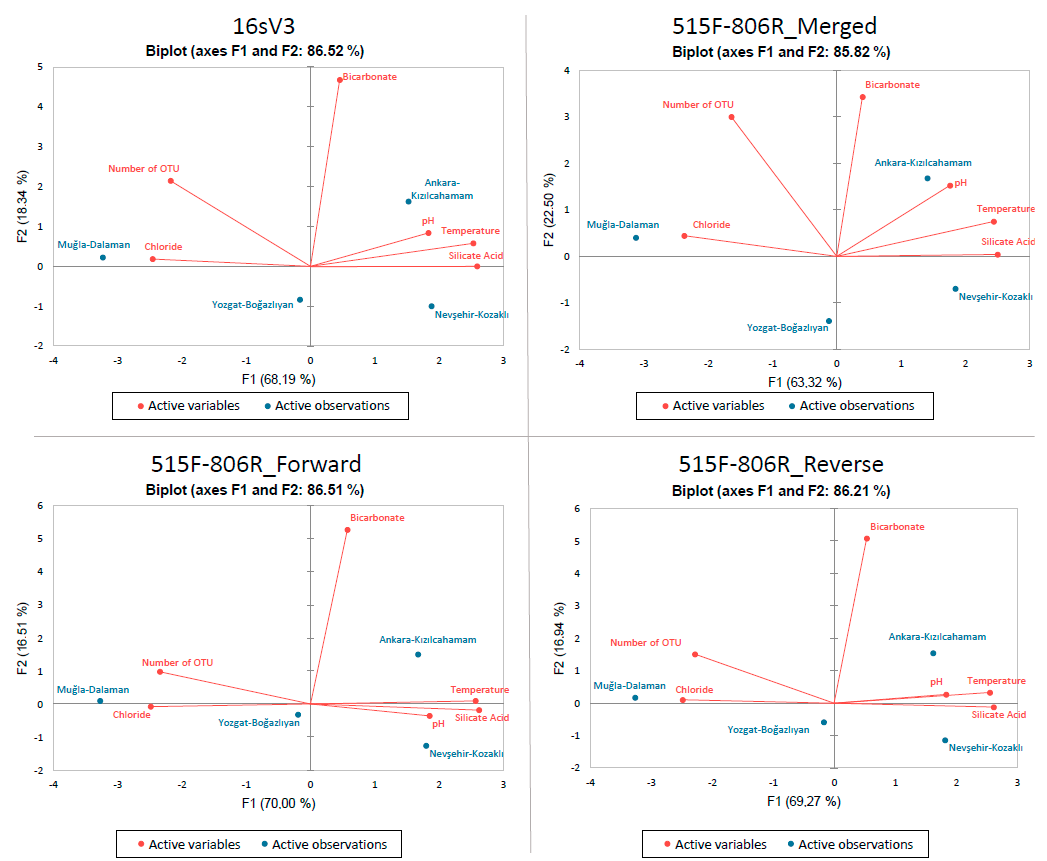
Figure 3. PCA of each online blast results obtained after c2l100 filtration. Fields are represented in blue color while physicochemical parameters and number of OTUs are represented with red. Results belong to the pool of triplicate PCR pools of 4 field samples (12 in total).